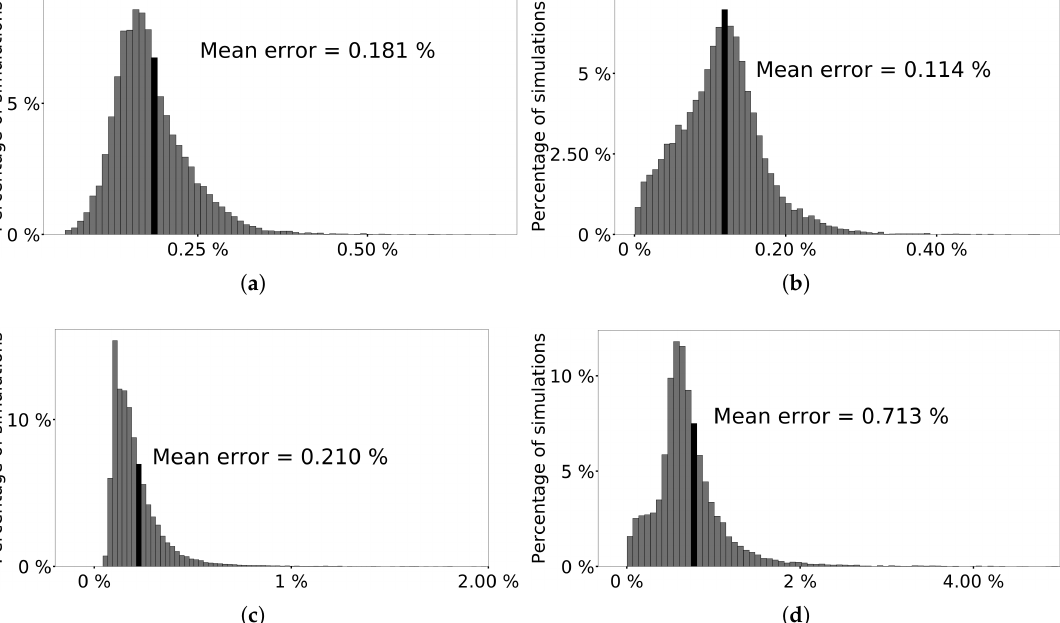
. The size of the vp